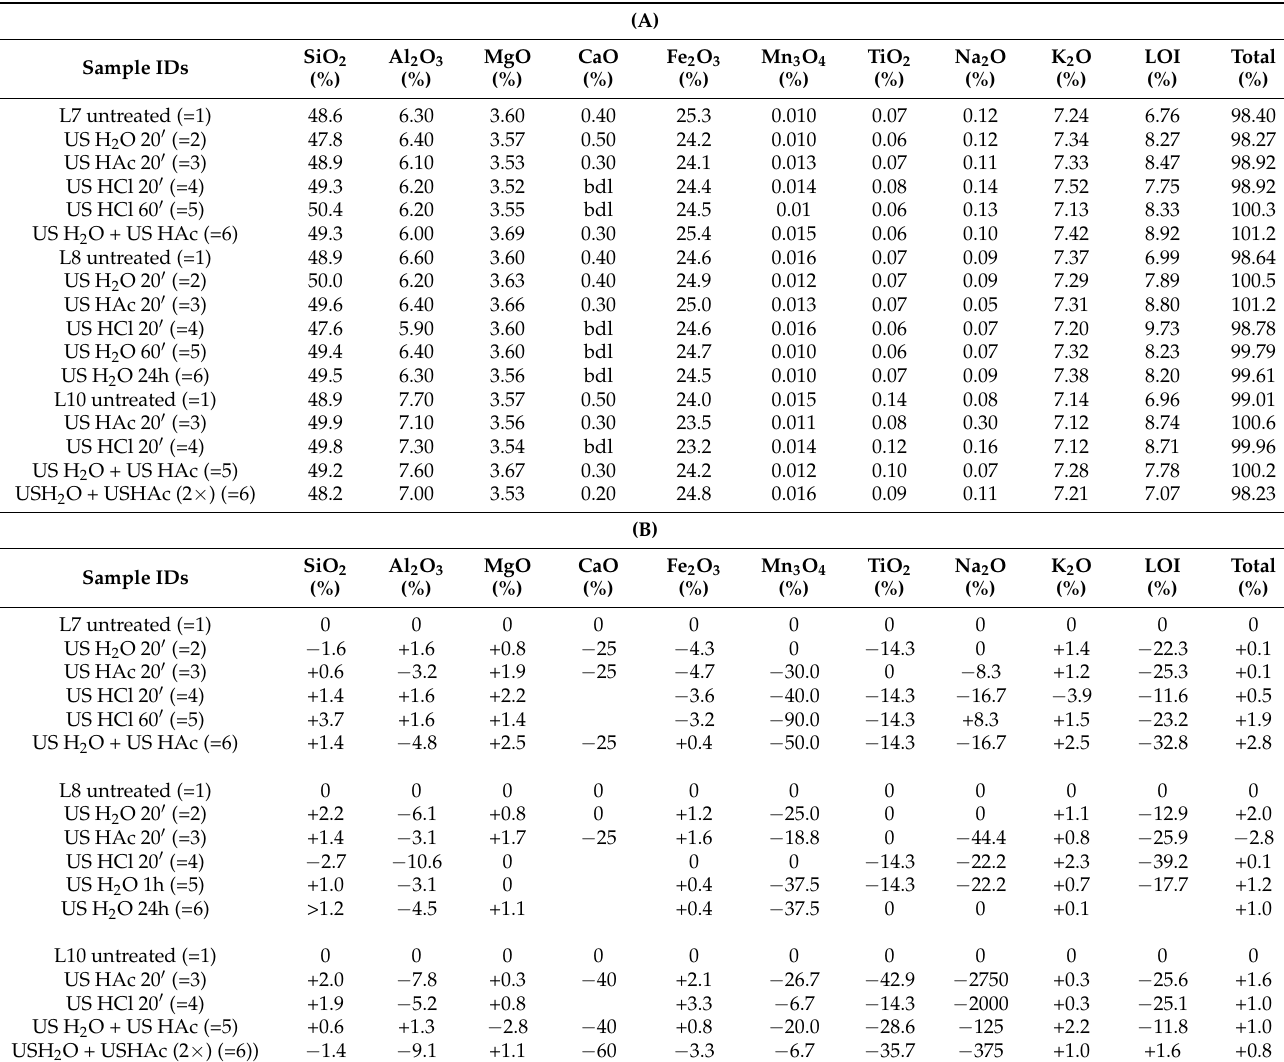
Table 1. (A) Contents of major elements in the untreated and leached glauconite pellets; (B) Positive and negative variations in the content of major elements of the leached separates, relative to the untreated reference sample. The numbers in brackets identify the successive aliquots; bdl stands for below detection